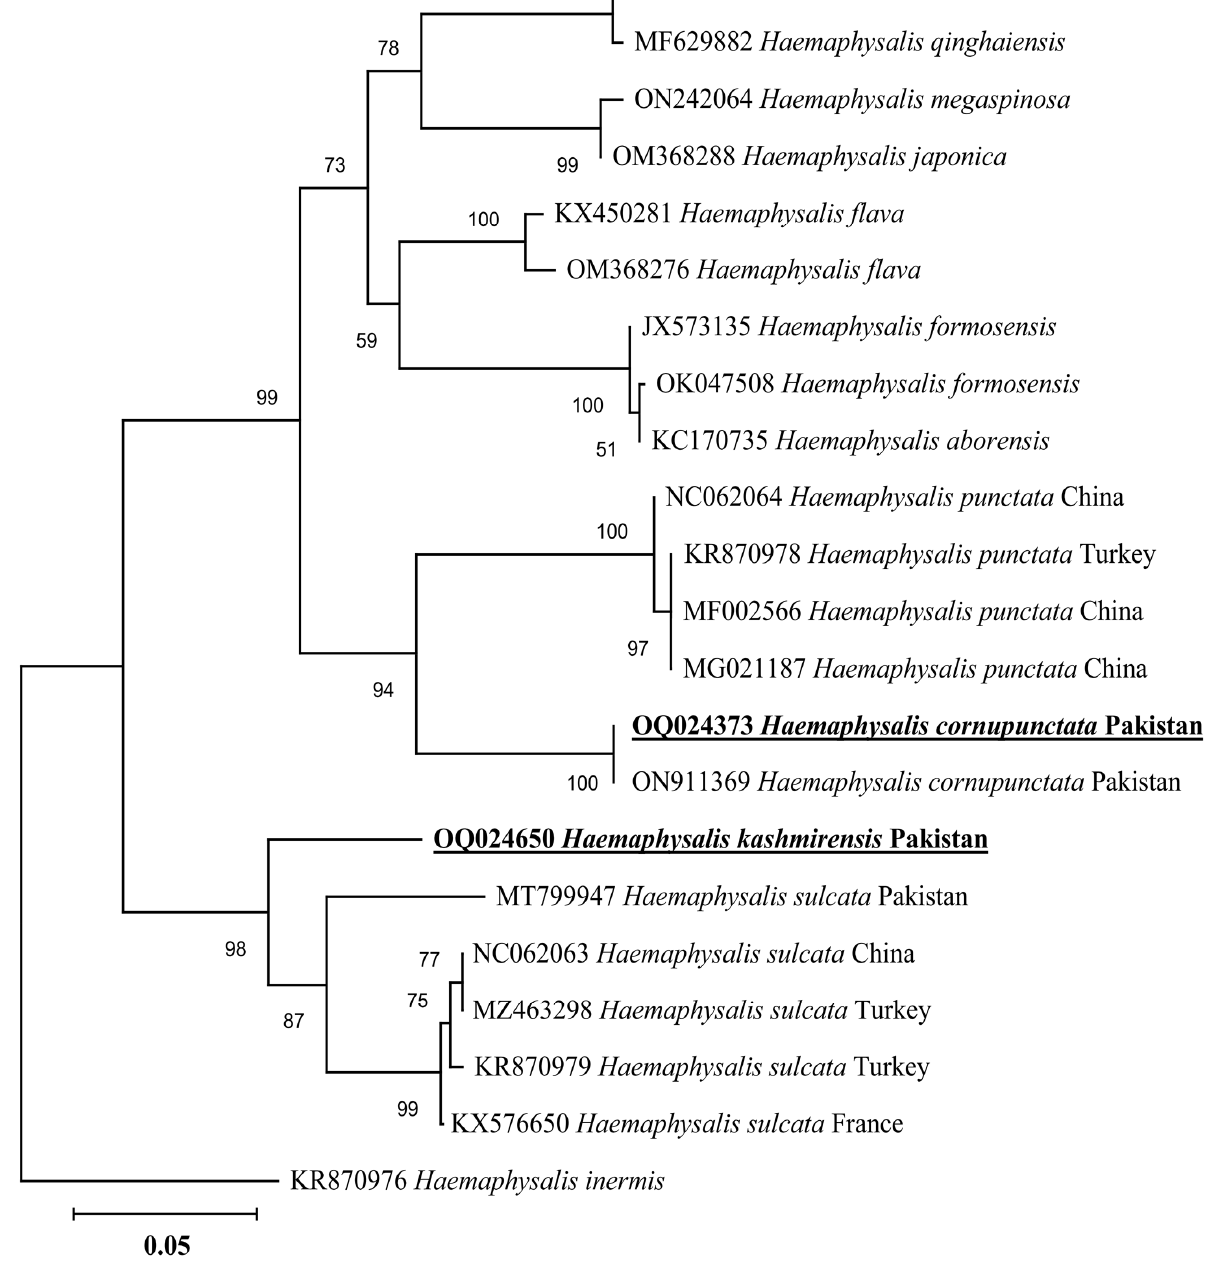
Figure 3. Neighbor ‐ Joining phylogenetic tree based on 16S rDNA of H. cornupunctata and H. kashmirensis . The 16S rDNA sequence of Haemaphysalis inermis was employed as an outgroup. All sequences have been denoted by their GenBank accession numbers, followed by species name and country name. The bootstrap values (1000 ‐ replications) are shown at each node. The sequences (OQ024373 and OQ024650) of the present study have been marked with bold and underlined fonts.